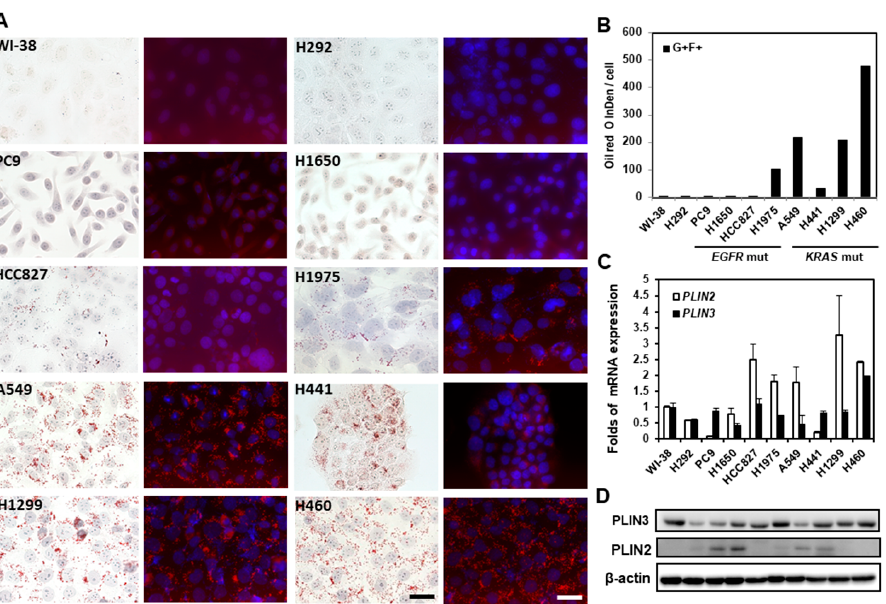
Figure 3. Oil droplet staining in lung cancer cell lines. ( A ) LDs in lung cancer cells were stained by ORO and recorded using Zeiss Axio Observer inverted light fluorescence microscope with Axiocam 512 color and 512 mono digital cameras. The fluorescence color emitted by Oil Red O was captured using a rhodamine filter set (Ex: 548 nm/Em: 580 nm, labeled in red) with nuceli counterstained with DAPI (labeled in blue). Images were recorded at 400 × magnification (scale bar, 50 µ m) ( B ) The amounts of LDs were measured using ImageJ. The fluorescence intensities of Oil Red O were integrated (IntDen value). The mRNA ( C ) and protein ( D ) expressions of PLIN2 and PLIN3 in the 10 cells were measured using real-time quantitative PCR and immunoblot analyses, respectively. The fold of mRNA expression change was calculated using 2 − ∆∆ Ct method with β -actin as the reference gene and compared with the expression level in WI-38 cells.